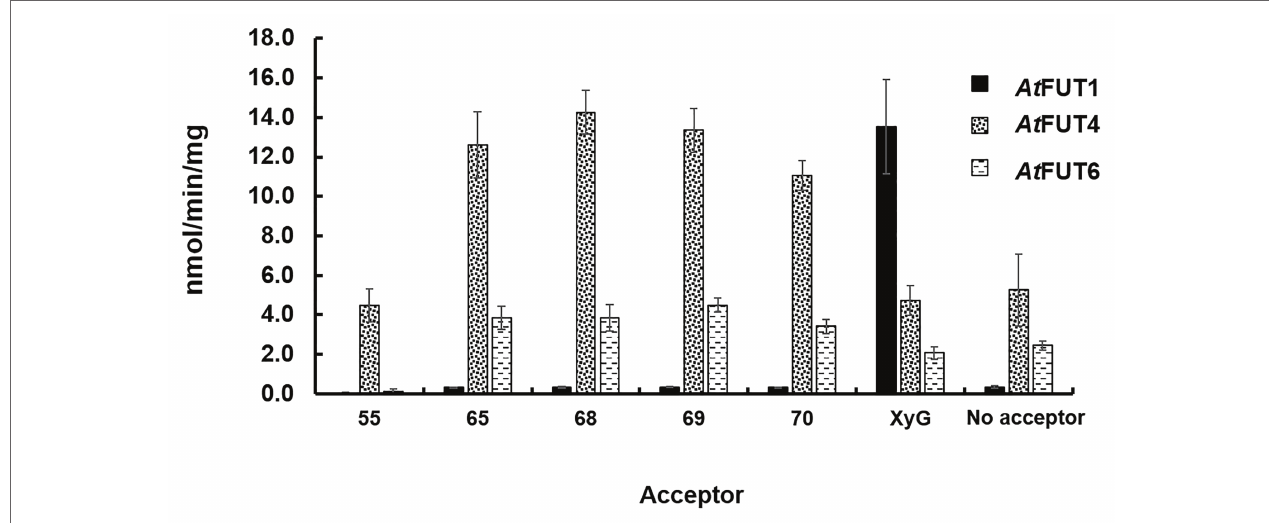
FIGURE 4 | Biochemical analysis of GFP- At FUT1, GFP- At FUT4, and GFP- At FUT6. Enzymatic activity was measured based on the production of GDP using the GDP-Glo assay kit in the presence or absence (Hydrolysis) of acceptor substrates ( Figure 2 ). Values are represented as the average of three technical replicates ±SD, and are reported in nmol/min/mg of